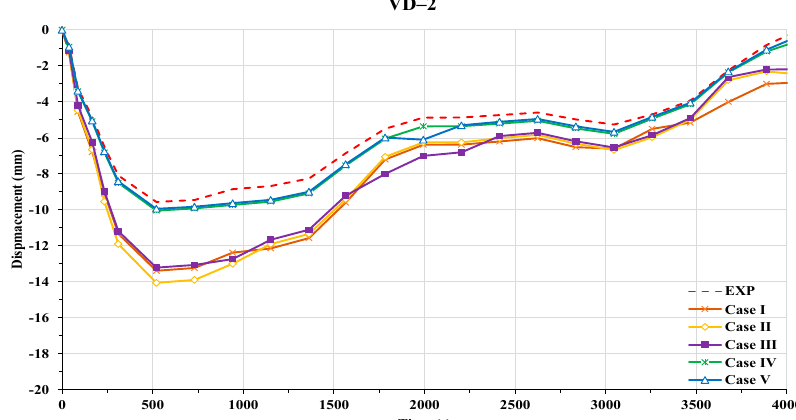
Figure 21. Displacement over time at VD-2.